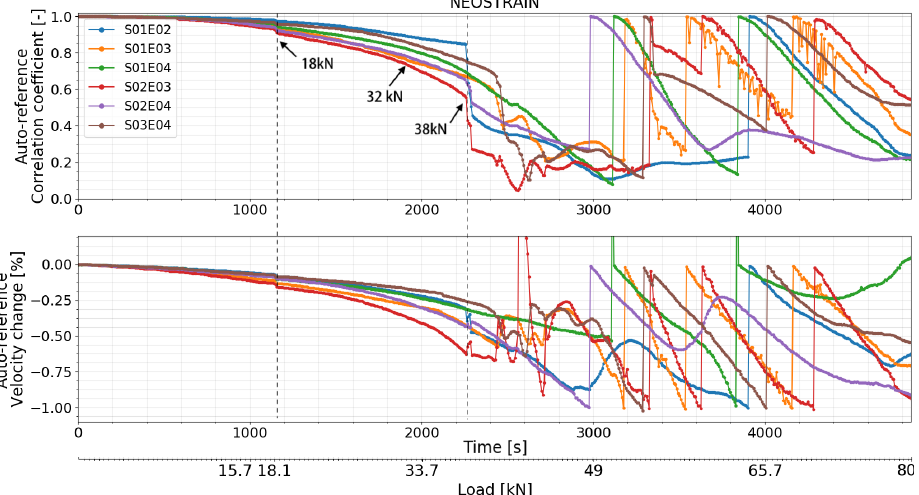
Figure 19. Correlation coefficient and relative velocity change of all the transducers combinations in test at NEOSTRAIN calculated by auto reference